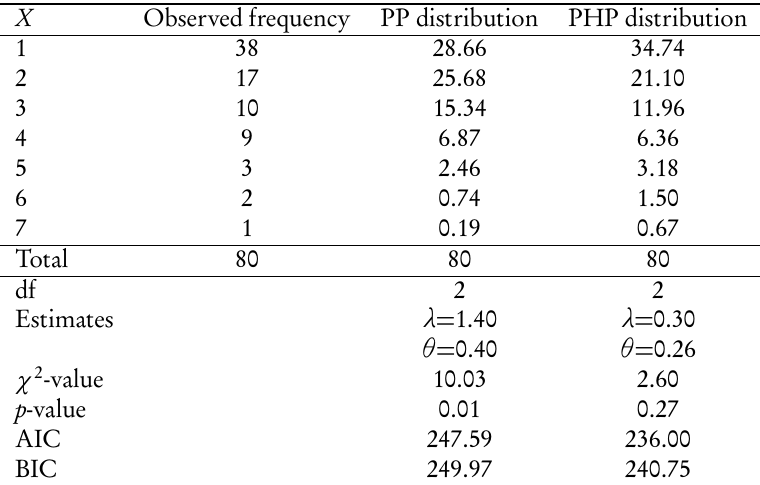
Distribution of number of European red mites on apple leaves, used by Jani and Shah (1979) and the expected frequencies computed using the positive Poisson and the PHP